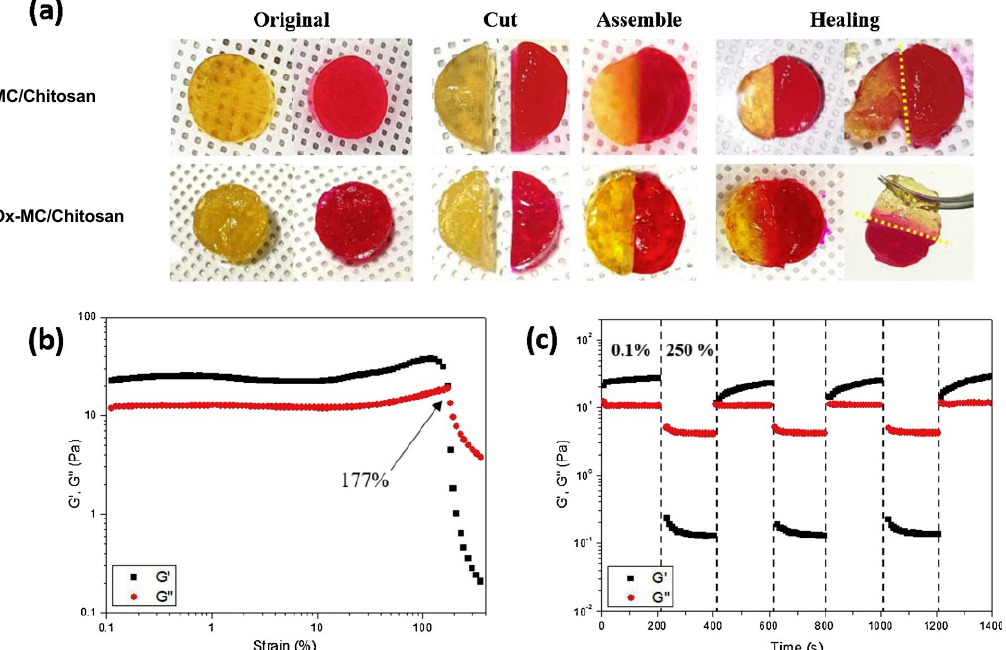
Figure 4. ( a ) Self-healing behaviors of MC/chitosan and Ox-MC/chitosan hydrogels after storage at 37 °C for 20 min. ( b ) Determination of the breaking strain of the Ox-MC/chitosan hydrogel via a strain-sweep test (strain range: 0.1–400%). ( c ) Self-healing behavior of Ox-MC/chitosan via a step-strain test with the application of 250% strain followed by 0.1% strain. All systems contained 8 wt% MC or Ox-MC and 1 wt% chitosan. Reproduced with permission from reference [101]. Copyright 2021 Elsevier.